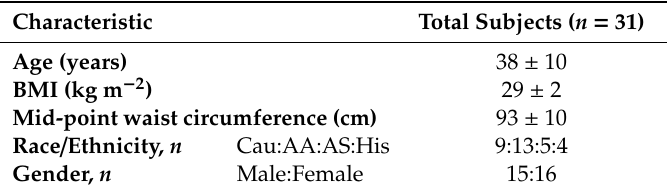
Table 2. Demographic information (Mean ± SD) 1 .